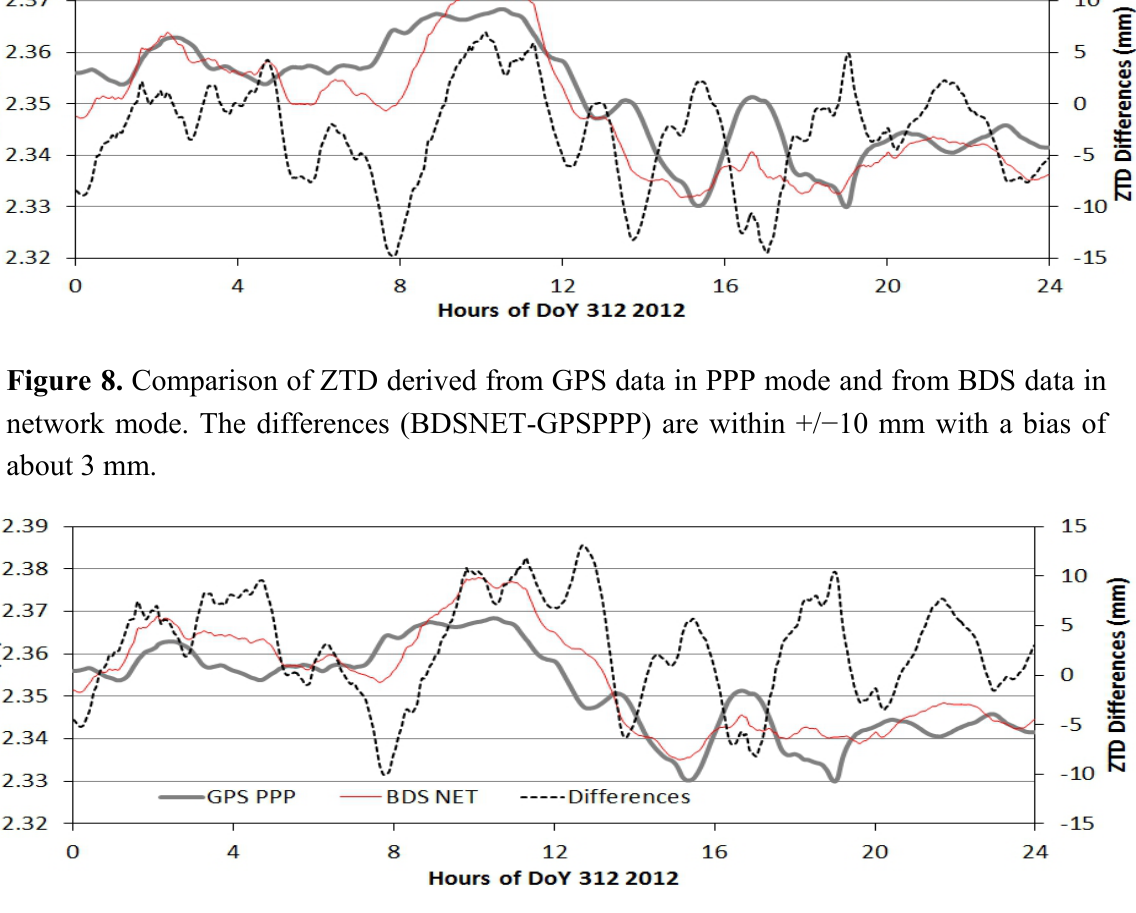
Figure 9. Comparison of ZTD derived from GPS data in PPP and network mode. The GPSNET ZTD has a larger variation than that of the GPSPPP. The differences (GPSNET-GPSPPP) are within +/ − 10 mm with a bias of about 2 to 3